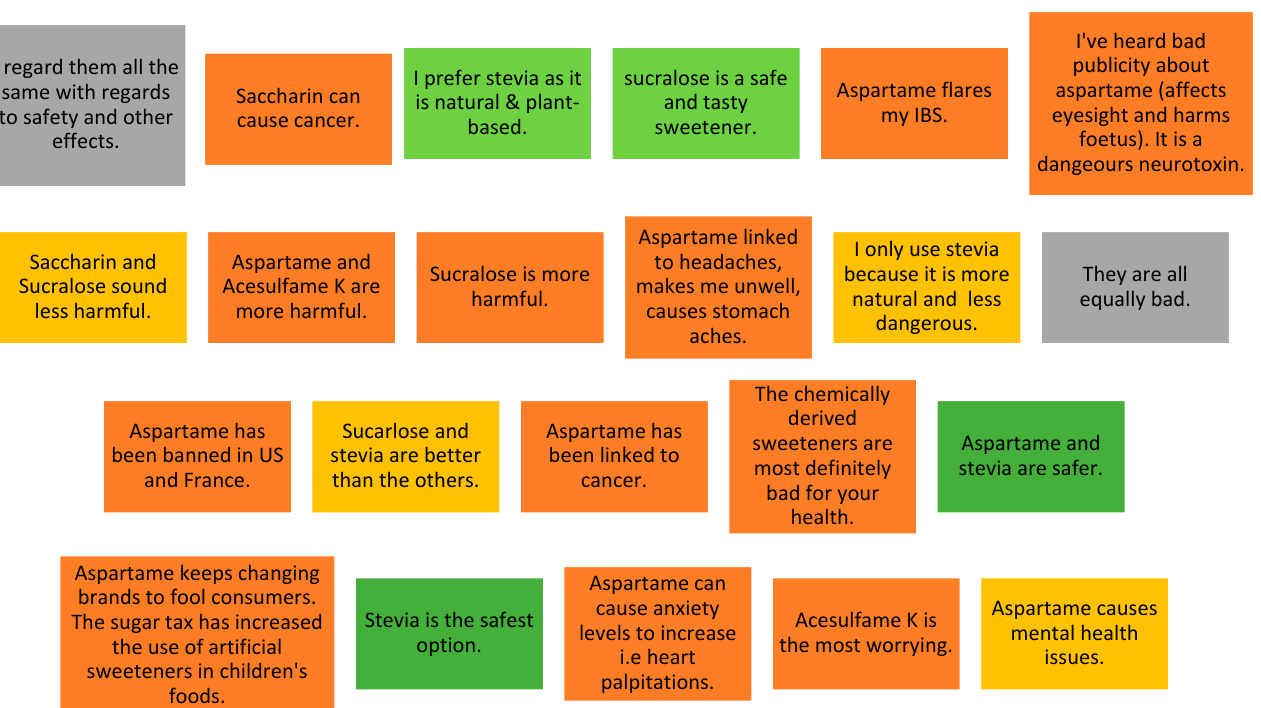
Figure 5. Preferred sources of information for dissemination of safety and benefits of NNS. Other responses included newspapers, schools, and health professionals (doctors, nurses).